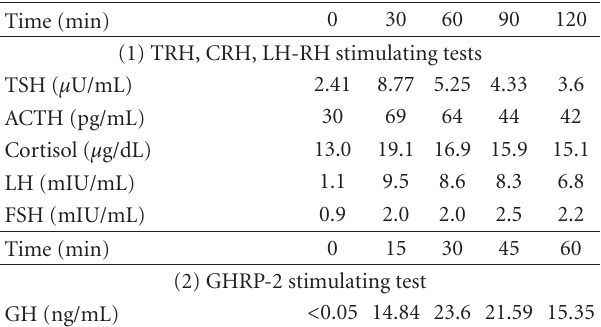
Table 2: Hormone stimulating tests on